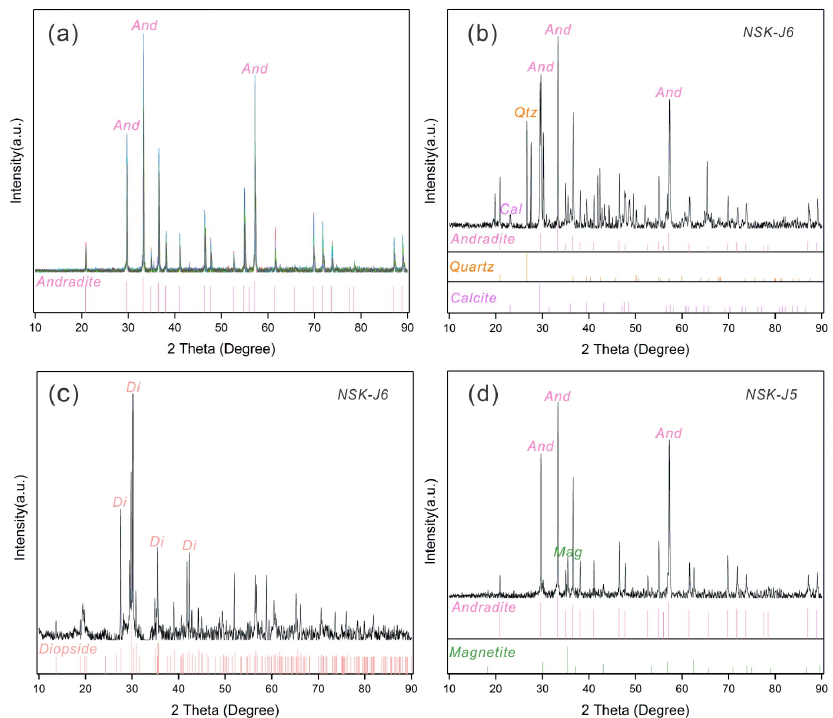
Figure 4. Representative XRD of garnet and wall rock samples. ( a ) Andradite; ( b ) andradite + quartz + calcite; ( c ) diopside; ( d ) andradite + magnetite.